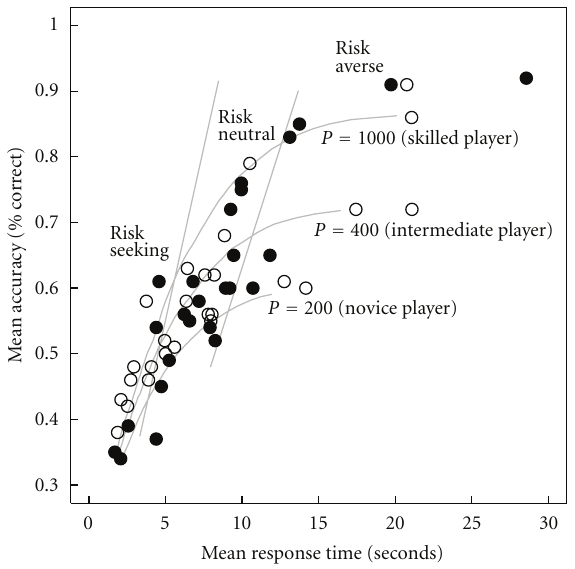
Figure 6: Data and particle filter model predictions from the experiment.